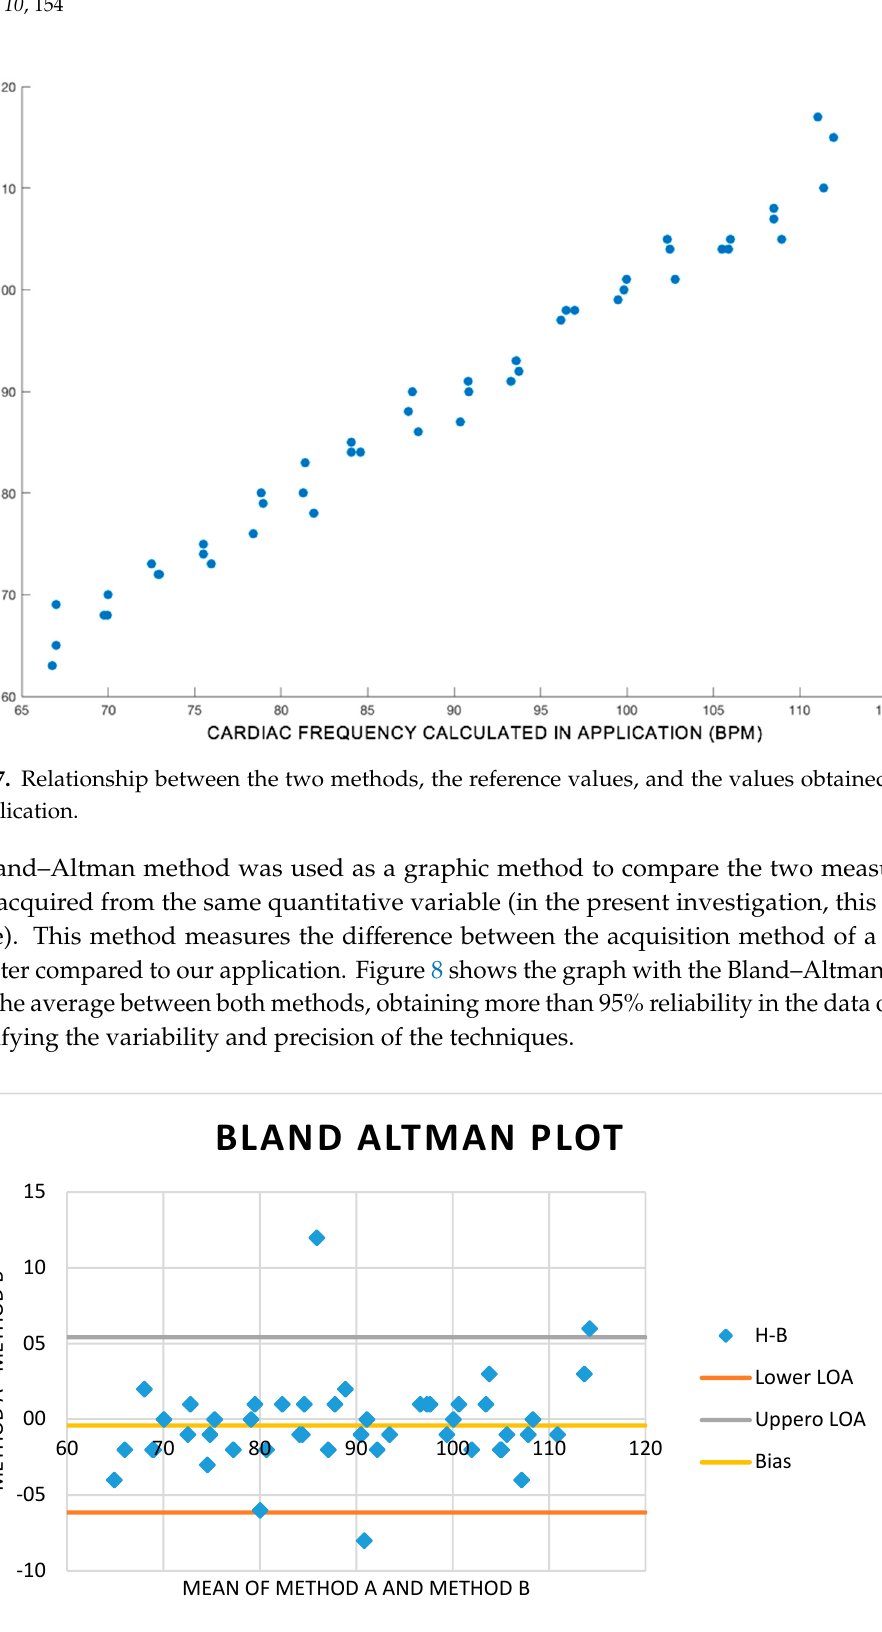
Figure 8. Bland–Altman plot between the reference values and the values obtained by our application. The average of the two measurements is plotted along the horizontal axis, and the difference between the two methods is plotted along the vertical axis.